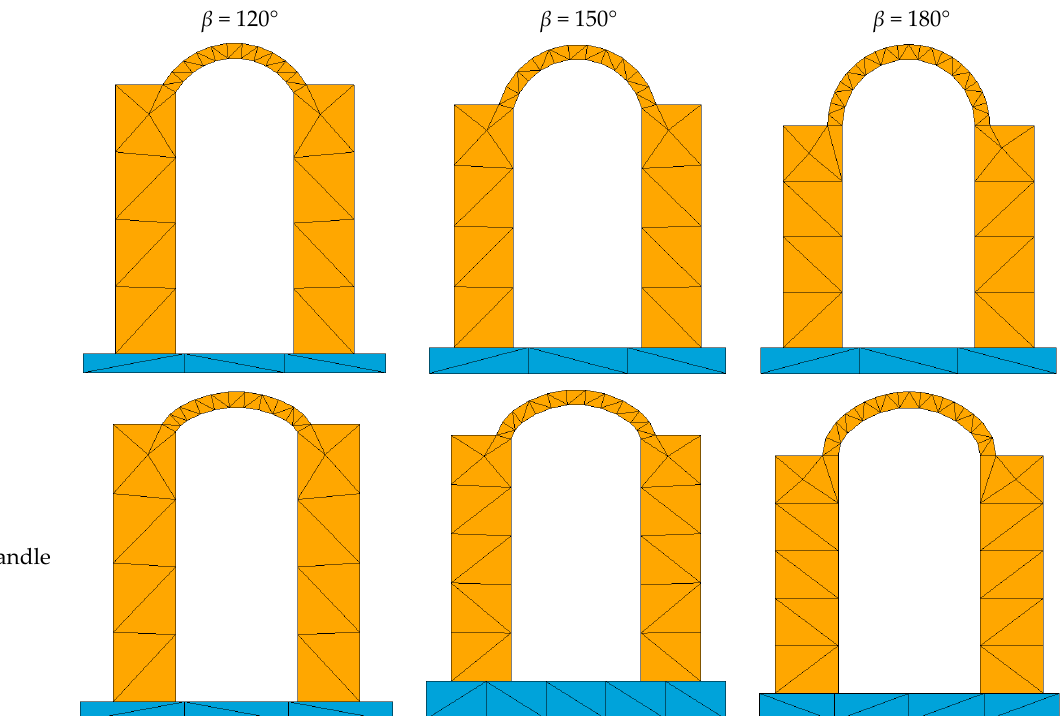
Figure 9. Mesh configurations of buttressed arches.